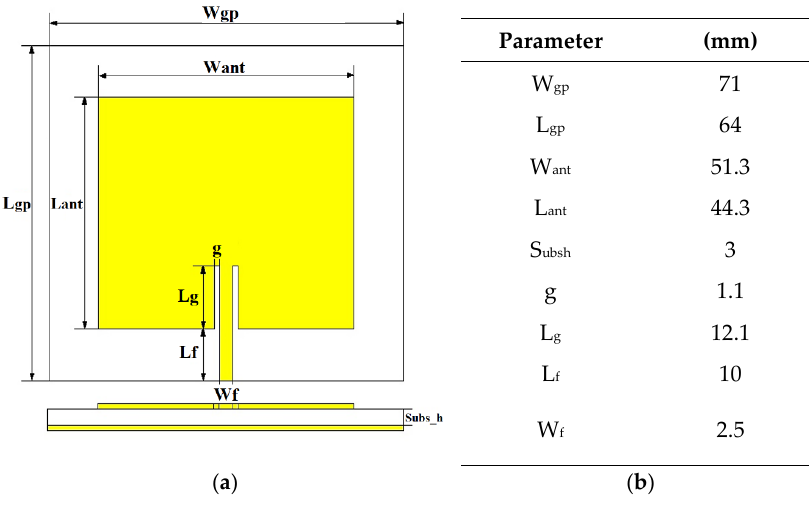
Figure 2. ( a ) Modelled textile antenna ( b ) Antenna parameter dimensions.